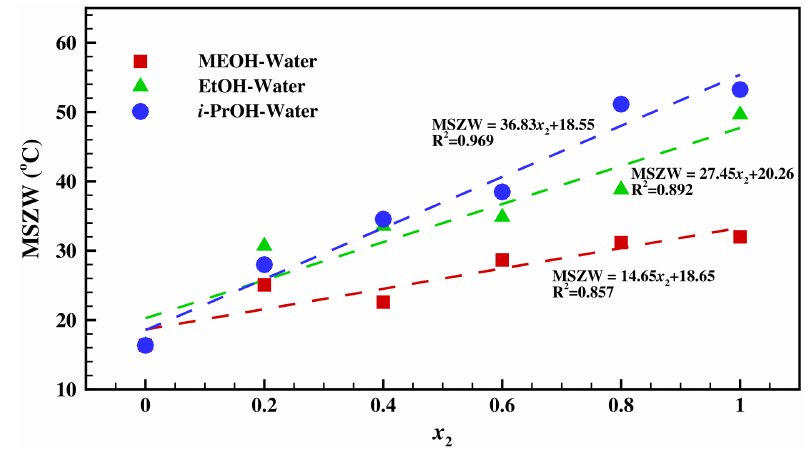
Figure 10. Plot of MSZW with alcohol composition in three binary solvent systems.